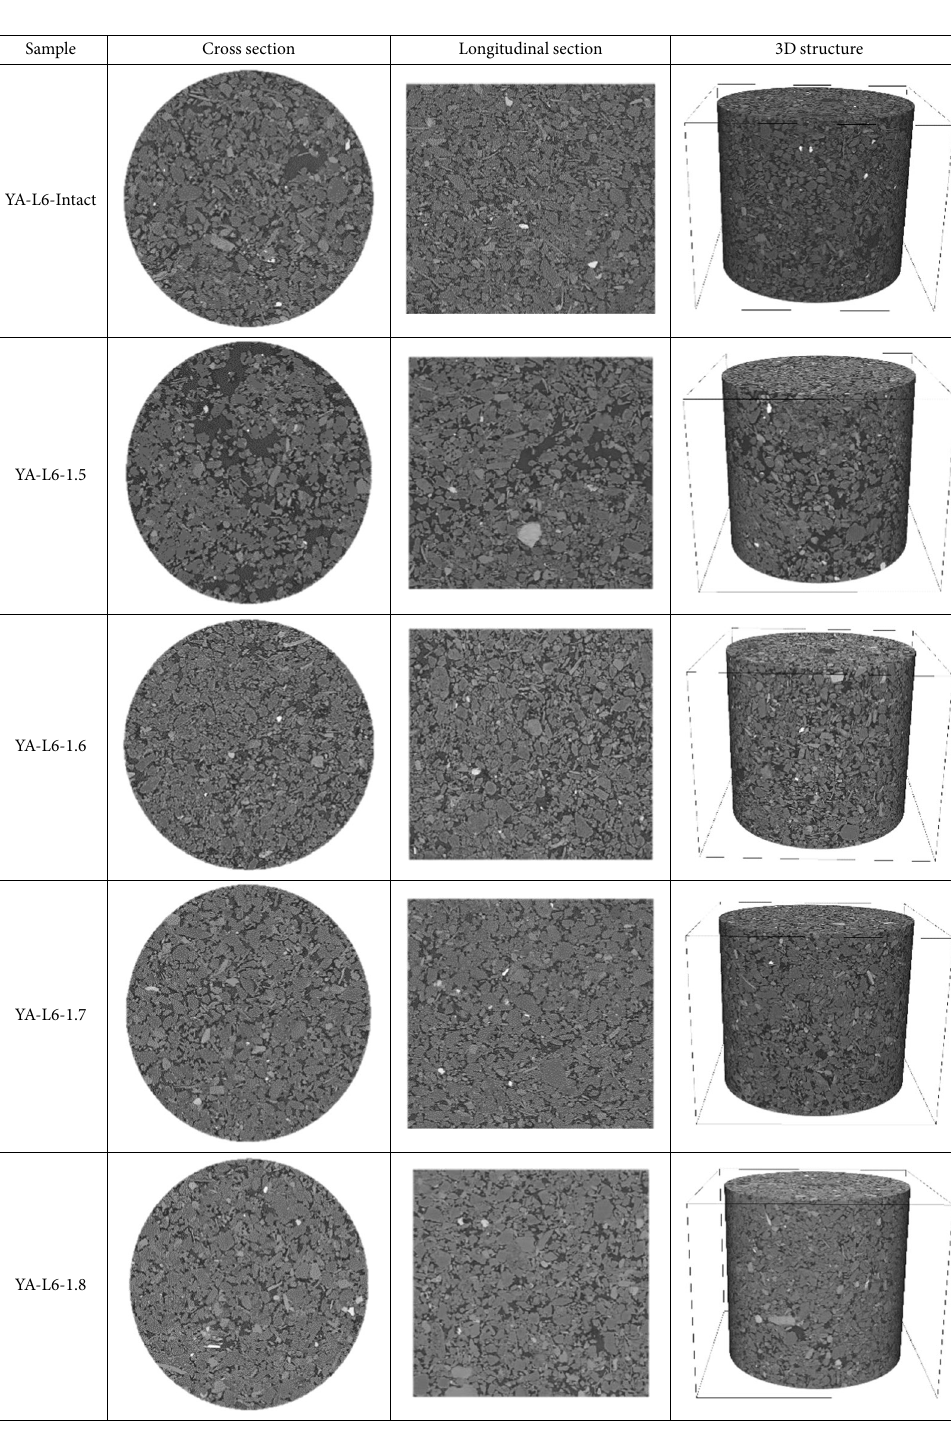
Table 6. The three-dimensional appearance of the scanned